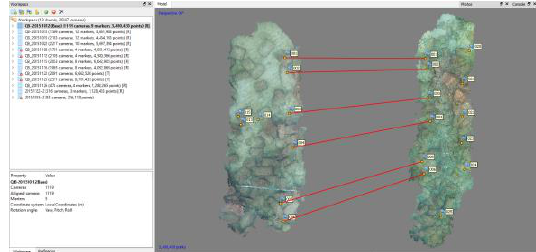
Figure 11. Markers for merging chunks (Mohamed Abdelaziz)